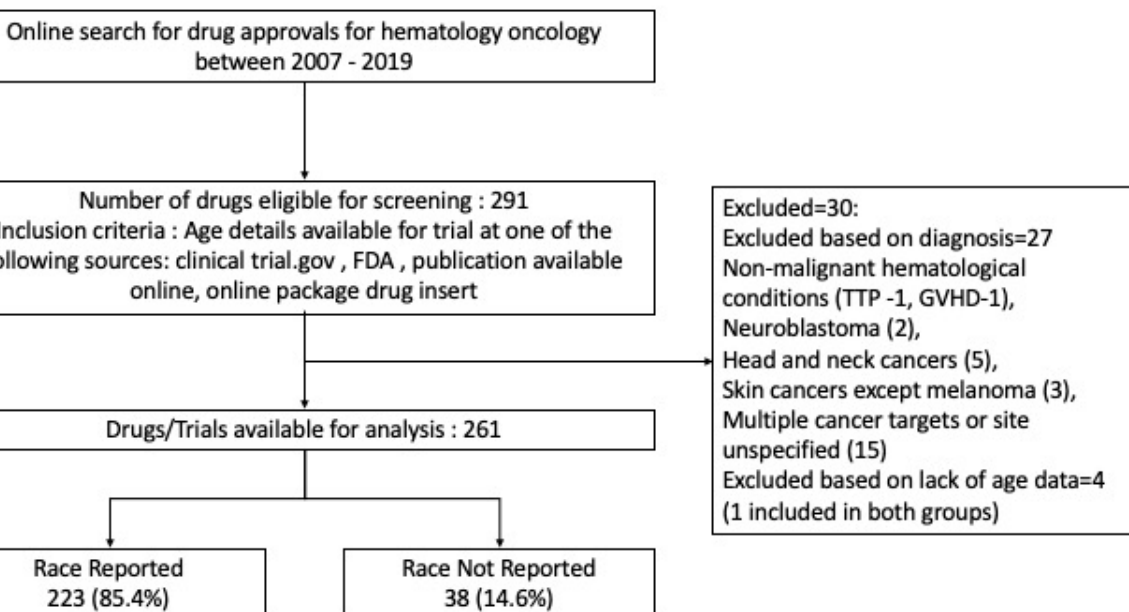
Figure 1. CONSORT Outlining the selection process for the study.